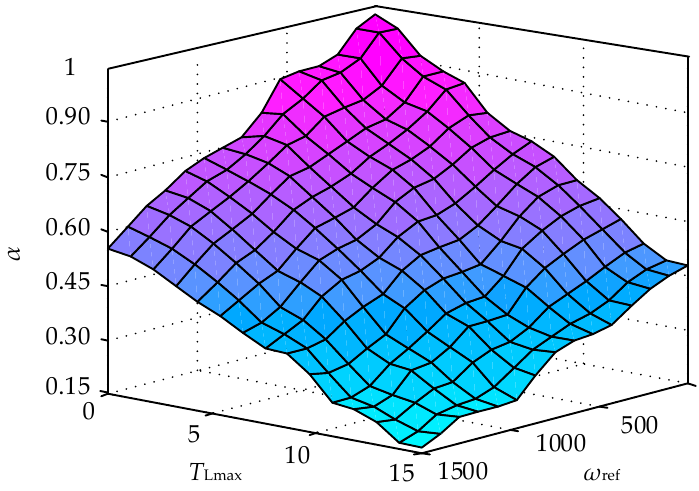
Figure 7. Input and output relationship of the fuzzy controller.